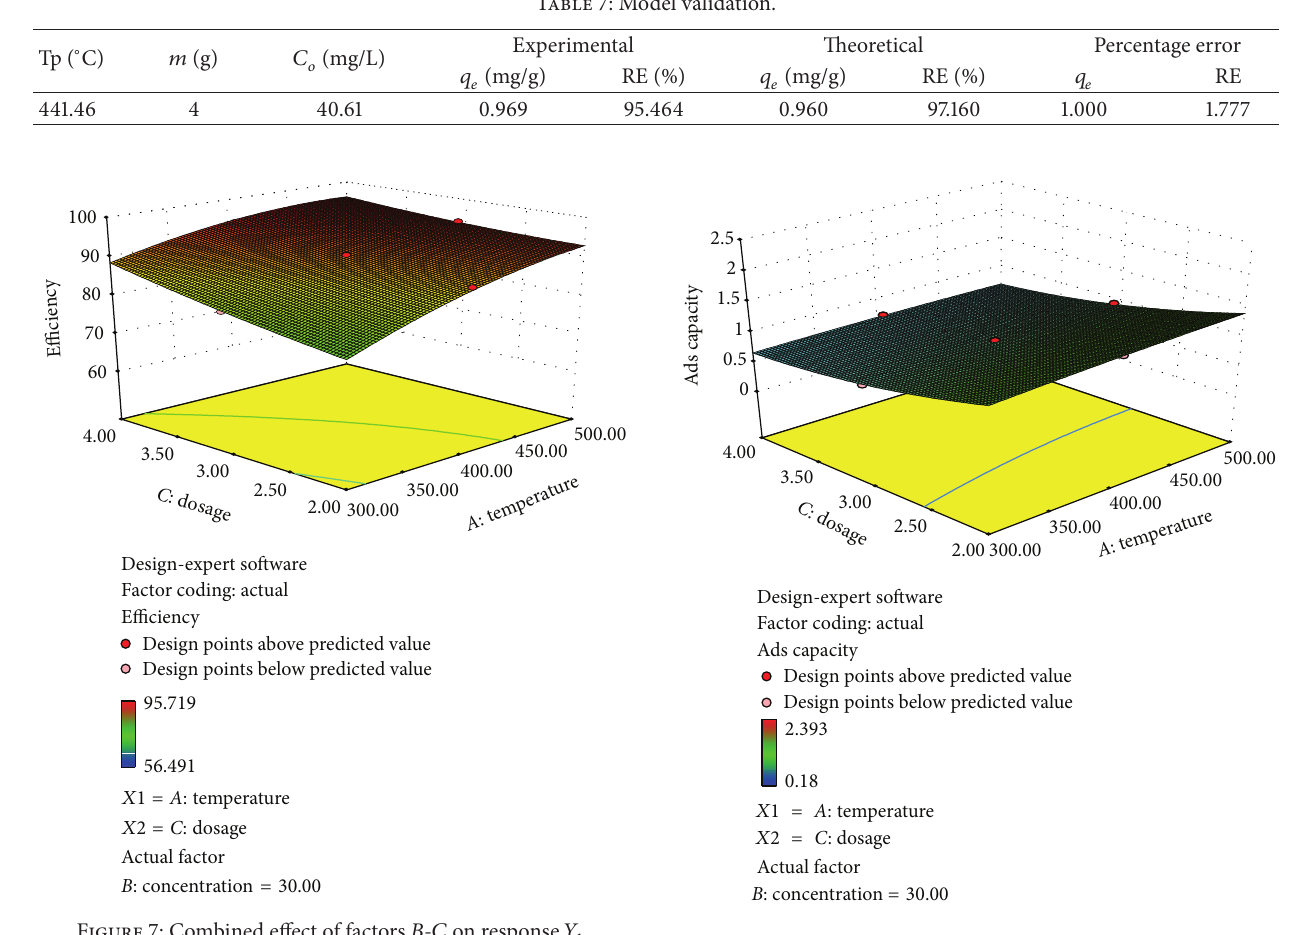
Figure 8: Combined effect of factors 𝐵 - 𝐶 on response 𝑌 2